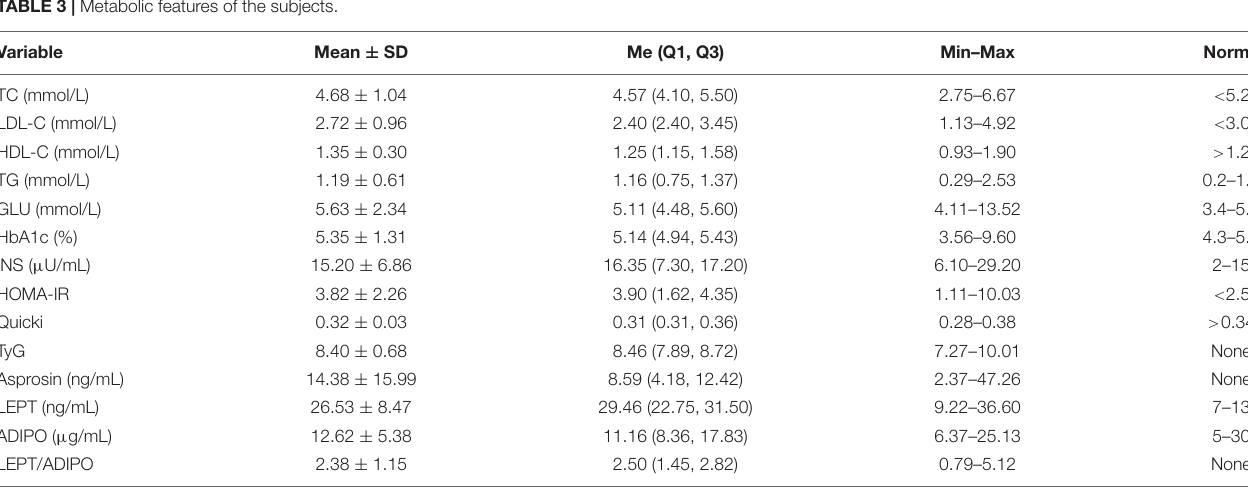
TABLE 3 | Metabolic features of the